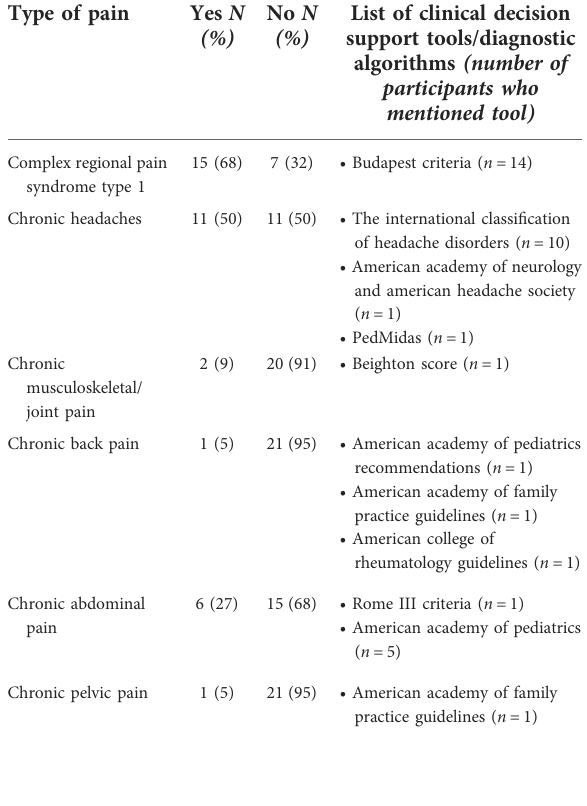
TABLE 4 Use of clinical decision support tools in accepting patients to interdisciplinary pediatric chronic pain programs. Type of